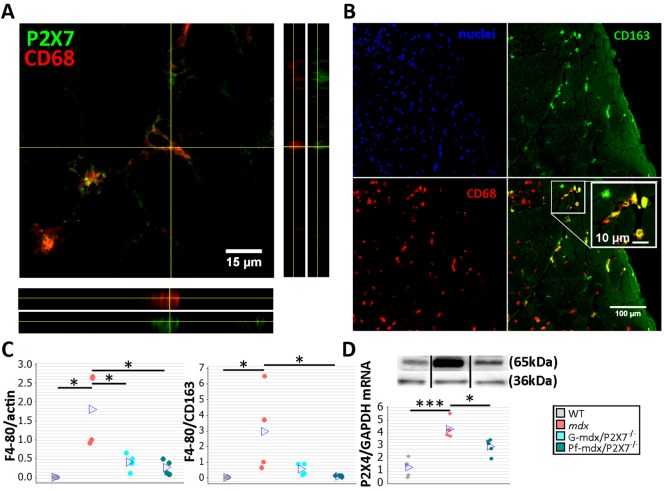

P2RX7 ablation in mdx mice reduces macrophage infiltration.(A) Immunofluorescence co-localization of CD68 macrophage marker with P2RX7. To confirm spatial co-localization, side and bottom panels show overlapping z-plane images. (B) M2 macrophage marker (CD163) co-localization with a subset of CD68-positive cells within the inflammatory infiltrate regions in mdx muscle. Blue signal identifies cell nuclei. (C) F4/80 macrophage marker levels shown as normalized average Western blot values (left) and F4/80 relative to CD163 (right). Significantly less F4/80 was found in Pf-mdx/P2X7−/− and G-mdx/P2X7−/− muscles compared to mdx muscles (Kruskal-Wallis H test, H = 7.73, df = 2, n = 4, p = 0.021; Mann-Whitney U test, Pf-mdx/P2X7−/− versus mdx, W = 26.0, n = 4, p = 0.030; G-mdx/P2X7−/− versus mdx, W = 26.0, n = 4, p = 0.030), while the ratio of F4/80 level to CD163 level, denoting M1/M2 macrophage ratio, was significantly reduced in Pf-mdx/P2X7−/− muscles (Kruskal-Wallis H test, H = 8.77, df = 2, n = 4, p = 0.012; Mann-Whitney U test, W = 26.0, n = 4, p = 0.030). (D) A representative Western blot (top) illustrating decreased P2RX4 protein levels, and corresponding qPCR data (bottom) showing decreased expression of P2RX4 mRNA in Pf-mdx/P2X7−/− gastrocnemius compared to mdx gastrocnemius (ANOVA, F = 25.96, df = 2, n = 5, p < 0.001; Tukey’s test, mdx versus C57, p < 0.001; Pf-mdx/P2X7−/− versus mdx, p = 0.017; Pf-mdx/P2X7−/− versus WT, p = 0.005). *p < 0.05, ***p < 0.001. Use of separate Western blots is indicated by solid black lines.